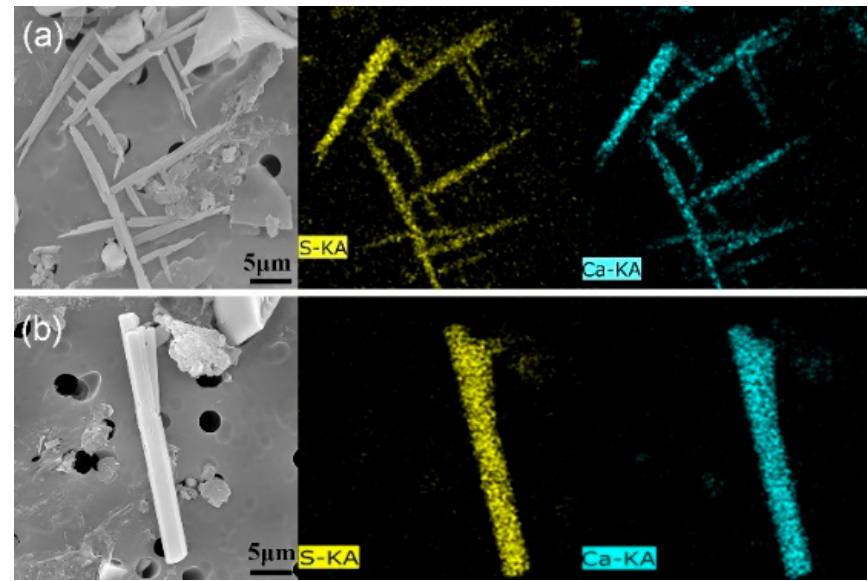
Figure 4. Element mapping of CaS inclusions in different morphologies. ( a ) Dendrite-like; ( b ) rod-like with branches.